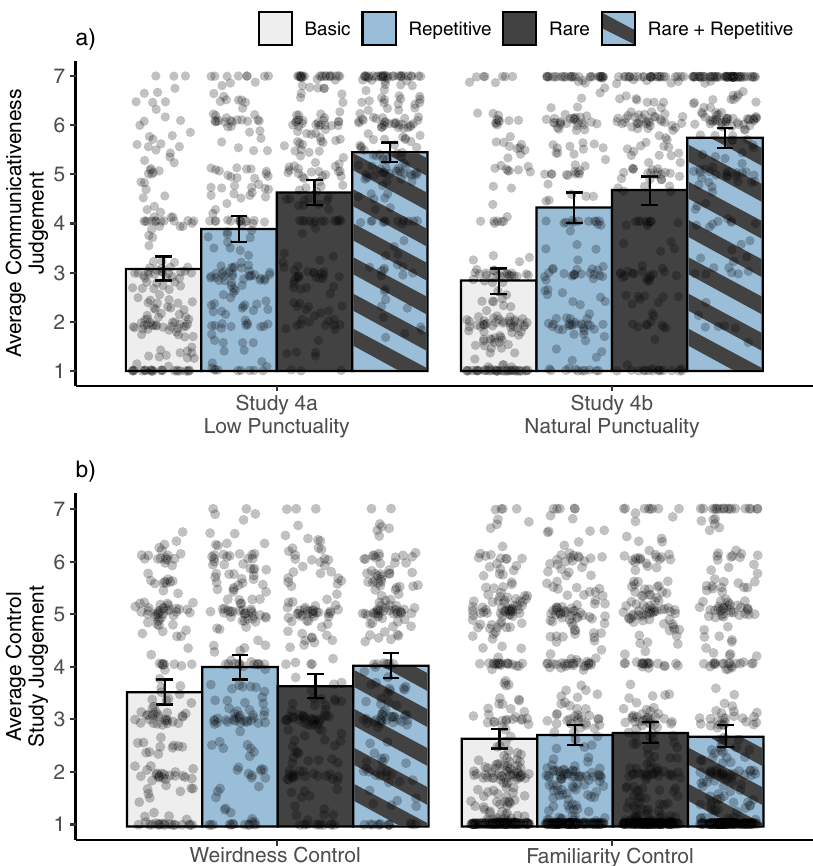
Fig. 5 Results from Study 4a, Study 4b, and the two controls. Each bar shows the average judgment and vertical lines show bootstrapped 95% con fi dence intervals. Dots represent individual judgments. a Average communicativeness judgments from US participants for Low Punctuality (Study 4a; n = 30) and Natural Punctuality (Study 4b, n = 30) demonstrators broken down by video type. b Results from the Weirdness Control and Familiarity Control studies. Participants ’ beliefs about a movement ’ s weirdness (Weirdness Control; n = 30) or familiarity (Familiarity Control; n = 60) failed to explain our